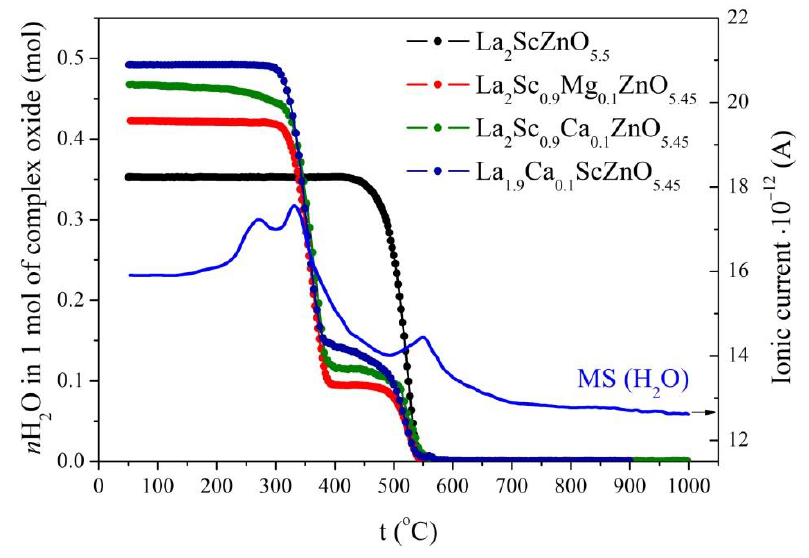
Figure 4. TG curves for hydrated La 2 ScZnO 5.5 , La 2 Sc 0.9 Mg 0.1 ZnO 5.45 , La 2 Sc 0.9 Ca 0.1 ZnO 5.45 , La 1.9 Са 0.1 ScZnO 5.45 and MS-curve for La 1.9 Са 0.1 ScZnO 5.45 .